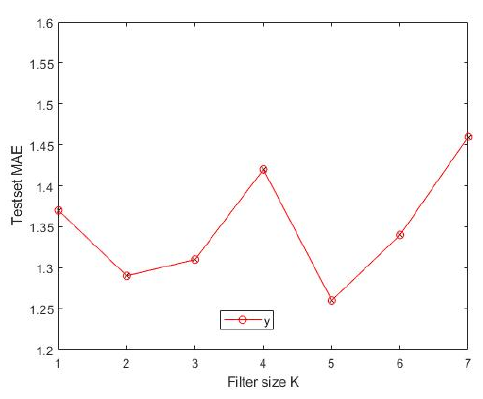
Figure 5. Effects of K .